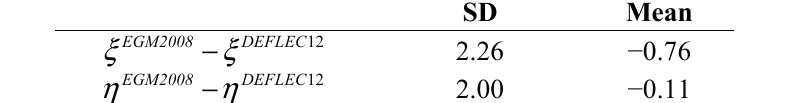
Table 3. DOV error of EGM2008 ( ″